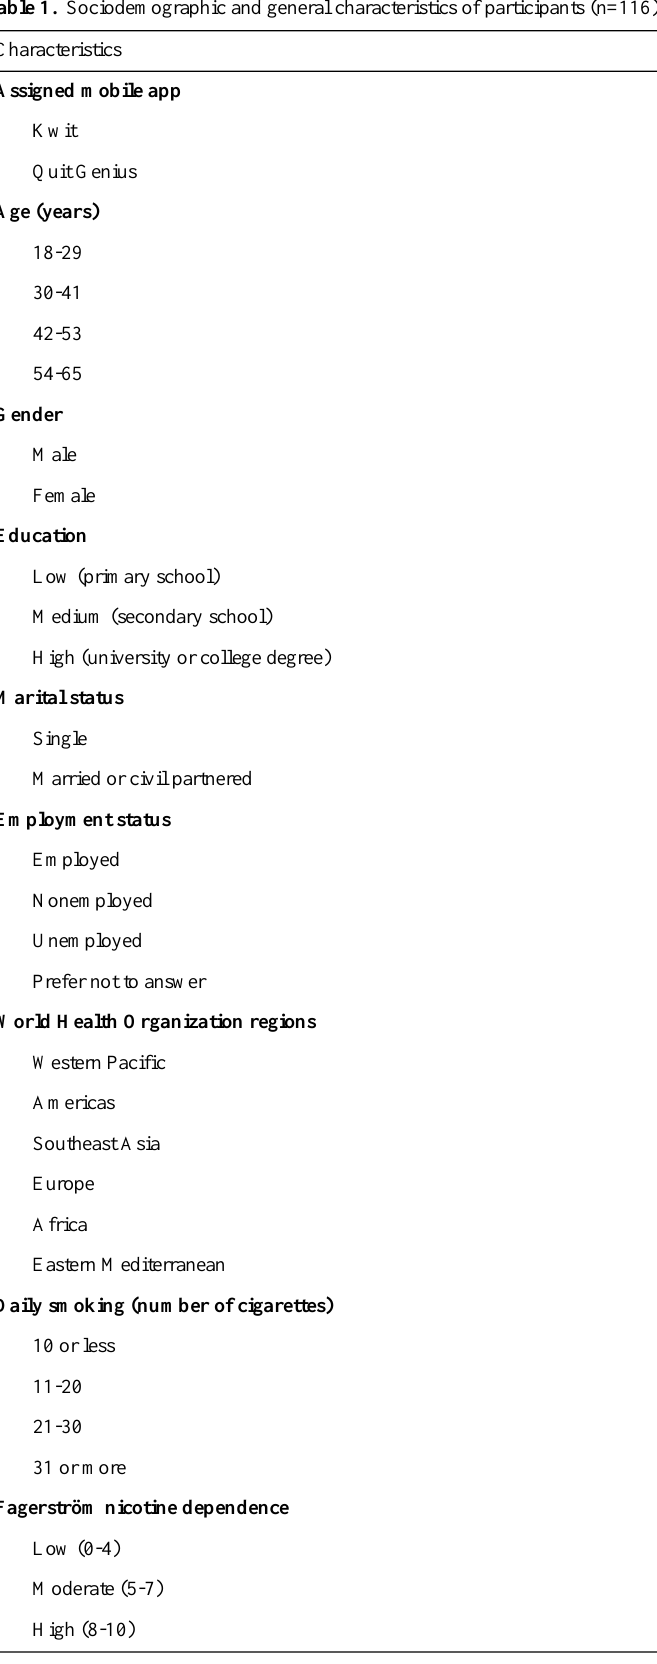
Table 1. Sociodemographic and general characteristics of participants